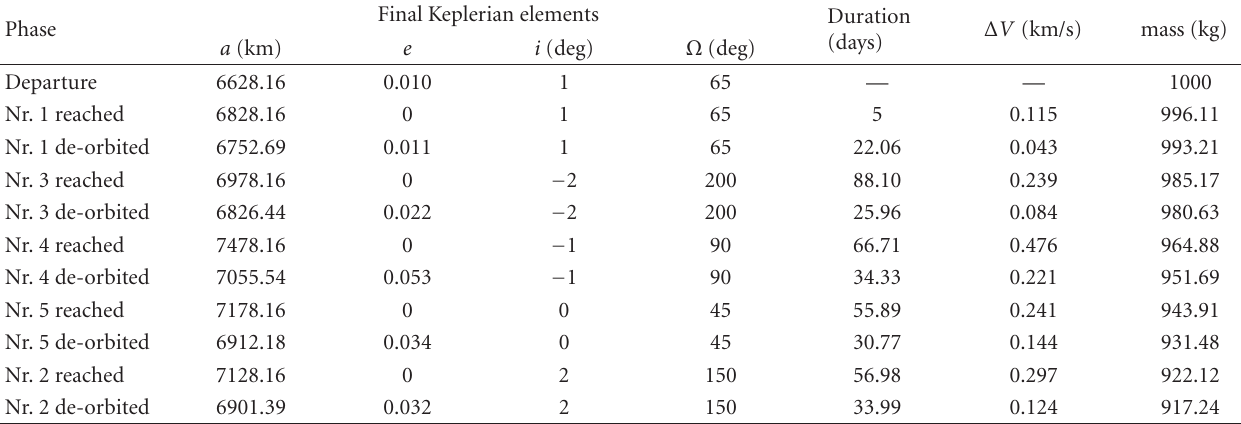
Table 8: Debris removal sequence and timing for minimum Δ V Tot .